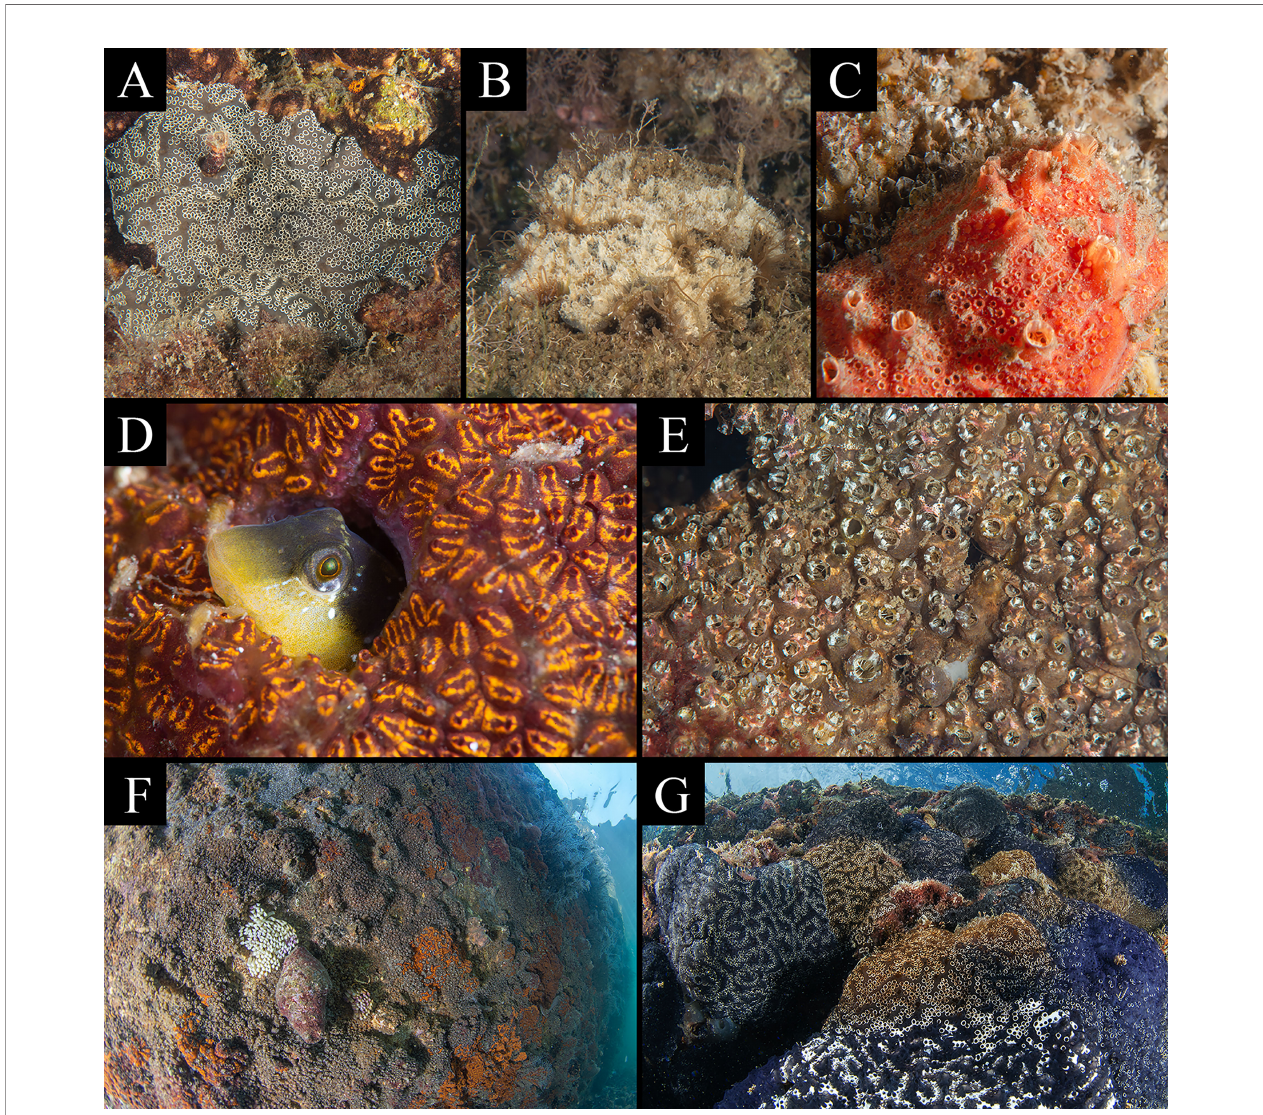
FIGURE 5 | Photographic evidence backdating NIS arrival in the Miseno Lake and impact of Distaplia bermudensis on dock wall communities (see Table 2 ). (A) Distaplia bermudensis , October 2019. (B) Aplidium accarense , September 2014. (C) Polyclinum constellatum (with P. zorritensis ), June 2014. (D) Botrylloides niger , June 2014. (E) Polyandrocarpa zorritensis , May 2014. (F, G) The Casevecchie channel before and after the arrival of D. bermudensis , with abundant colonies of P. zorritensis and B . niger (left, August 2015) and colonies of D. bermudensis (of different colours) colonizing the same dock wall area (right, March